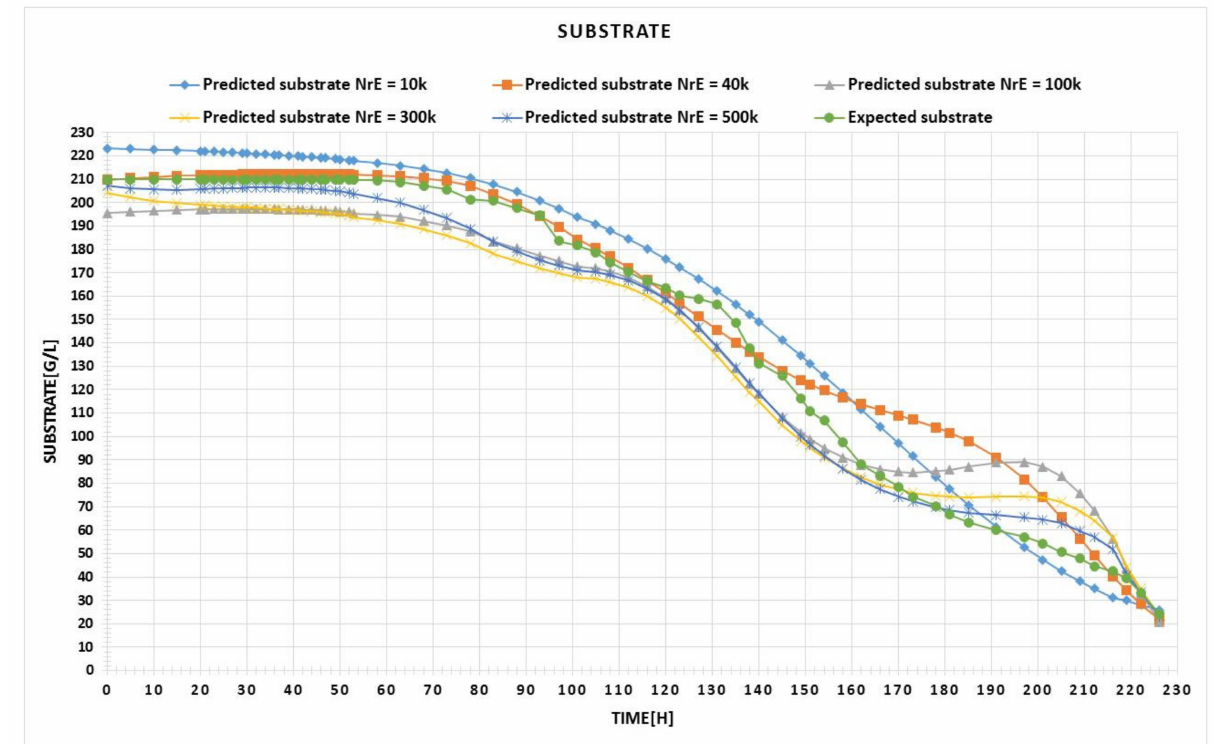
Figure 14. The influence of the number of epochs on the amount of substrate, with a learning rate = 0.7.